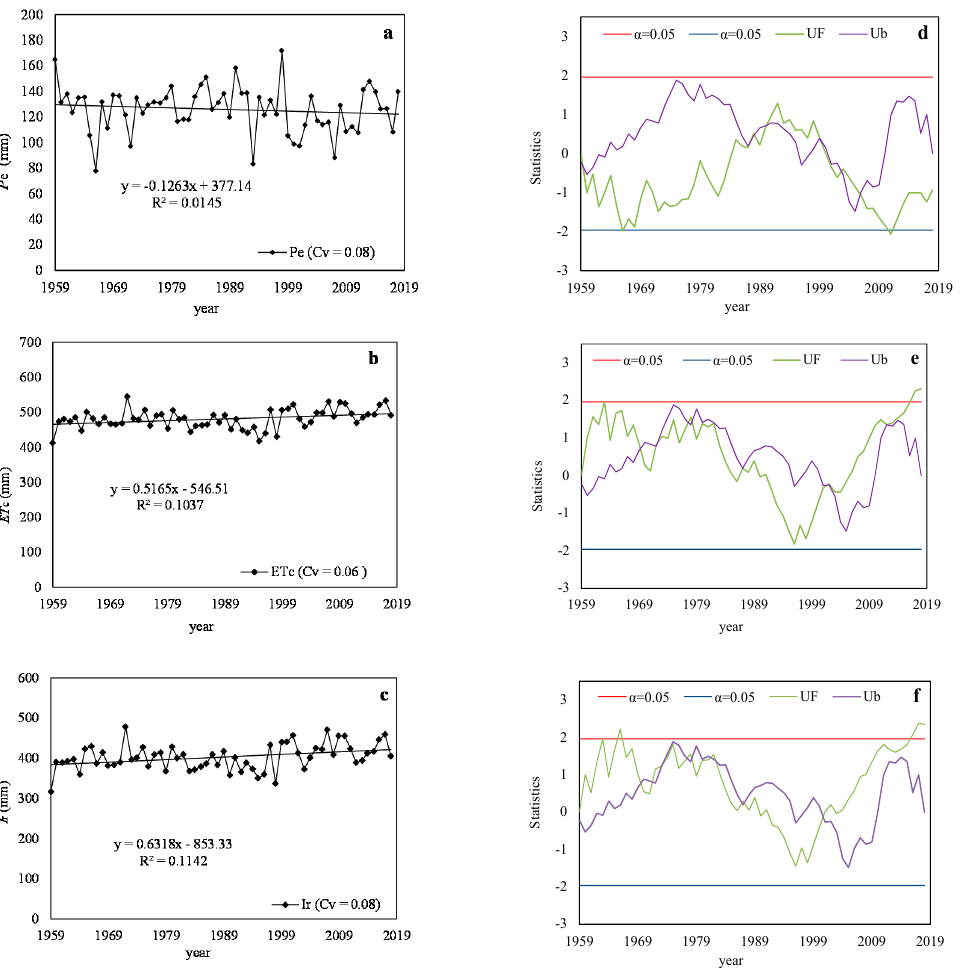
Figure 3. The temporal variation of P e , water requirements ( ET c ), and irrigation water requirements ( I r ) during the entire growth period in Inner Mongolia and the abrupt test of the three. ( a ) The temporal variation of P e ; ( b ) the temporal variation of ET c ; ( c ) the temporal variation of I r ; ( d ) P e abrupt test; ( e ) ET c abrupt test; ( f ) I r abrupt test).